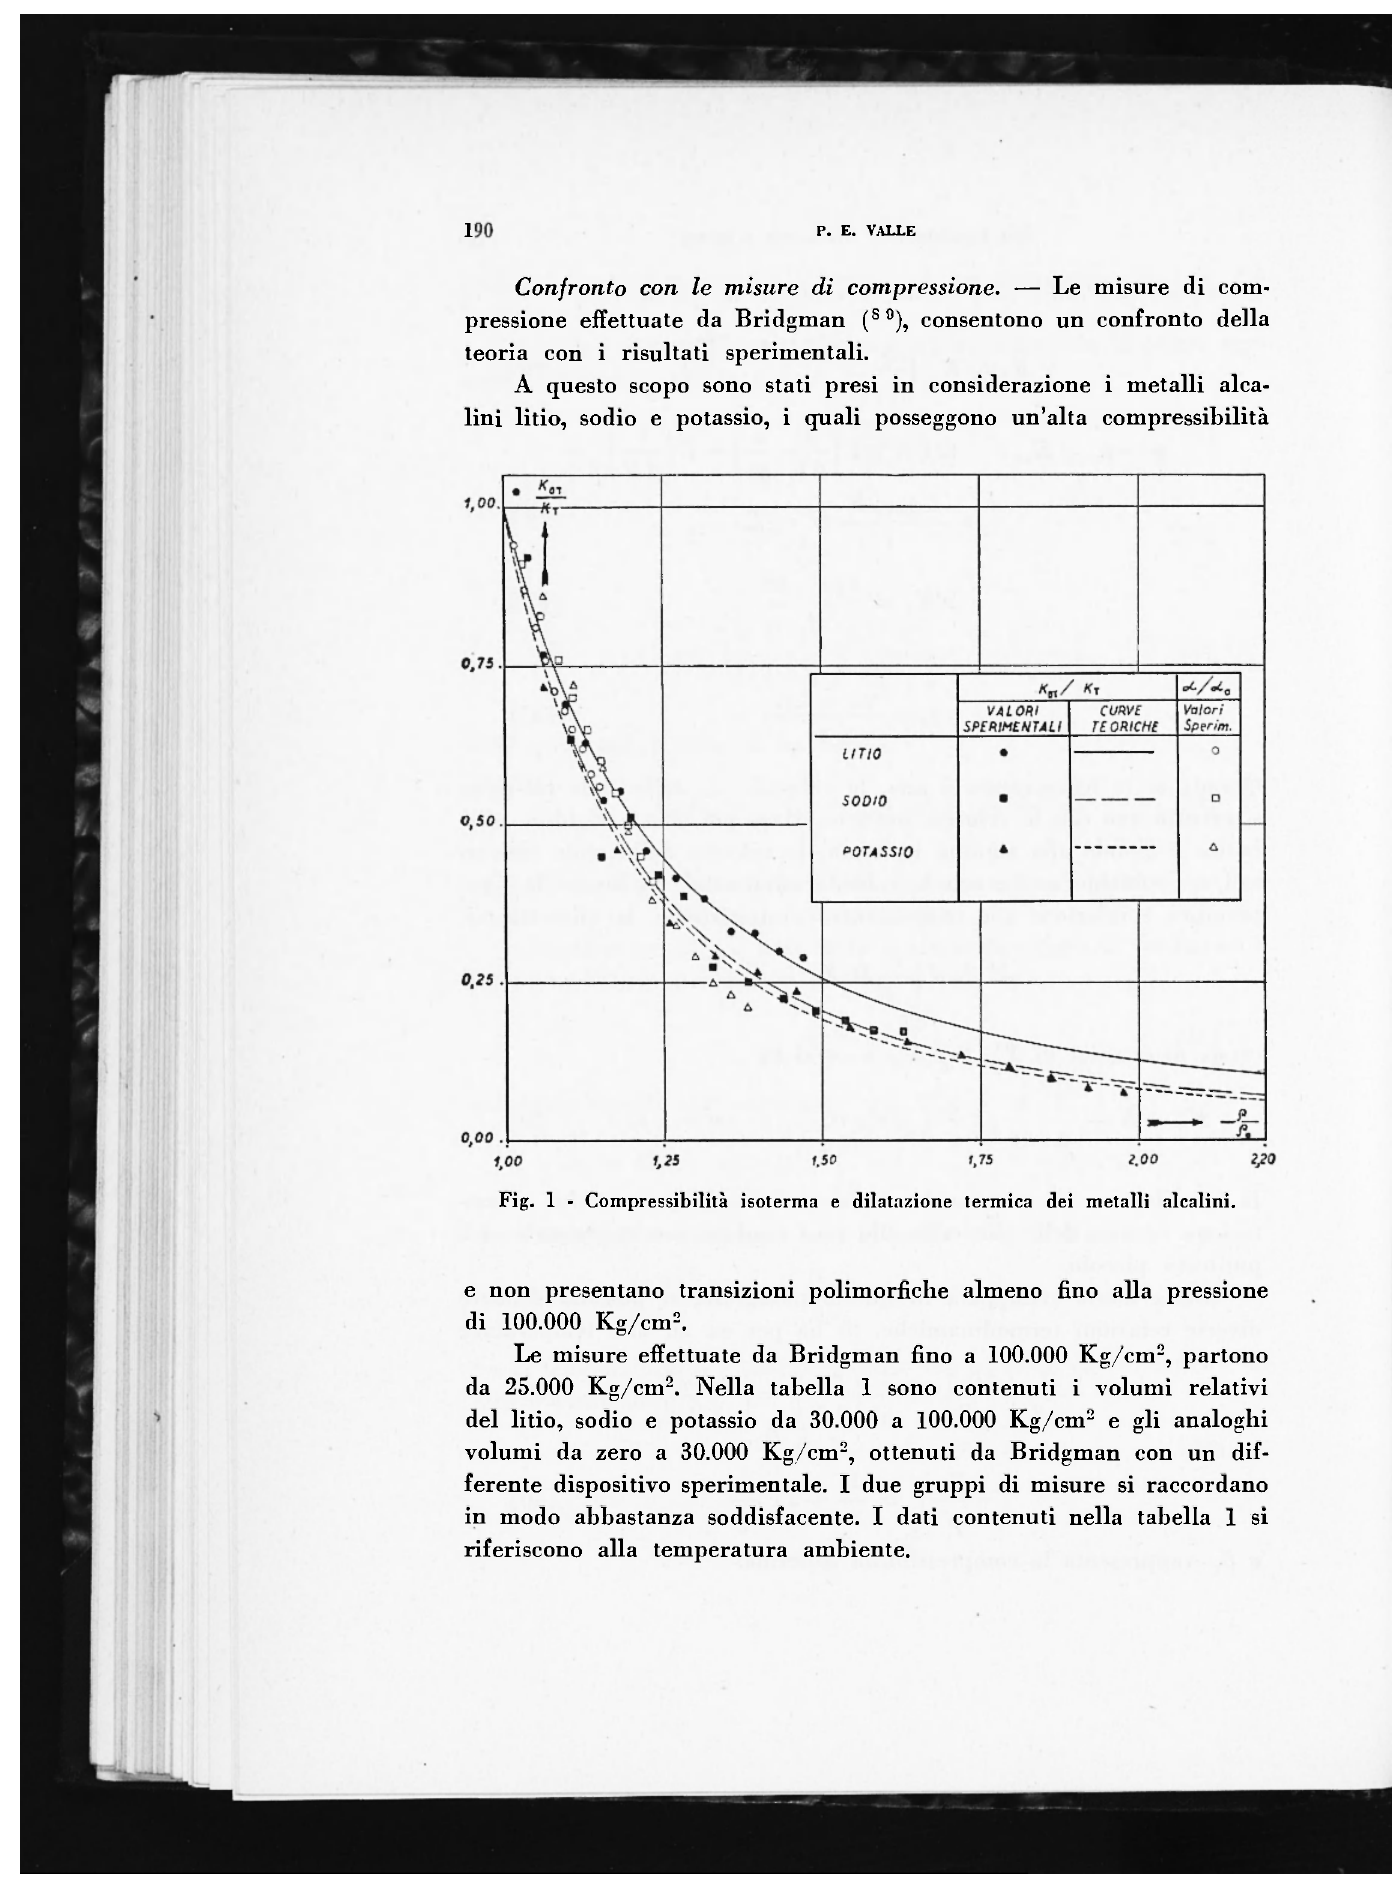
e non presentano transizioni polimorfiche almeno fino alla pressione di 100.000 Kg/cm 2